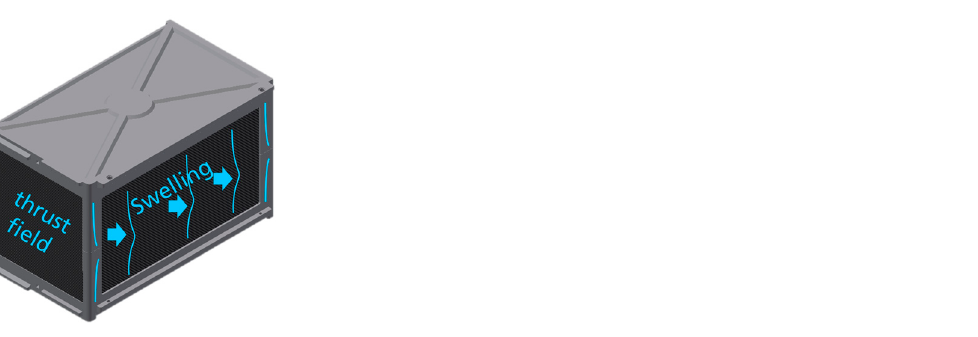
Figure 6. Concept for joining the battery module housing parts.